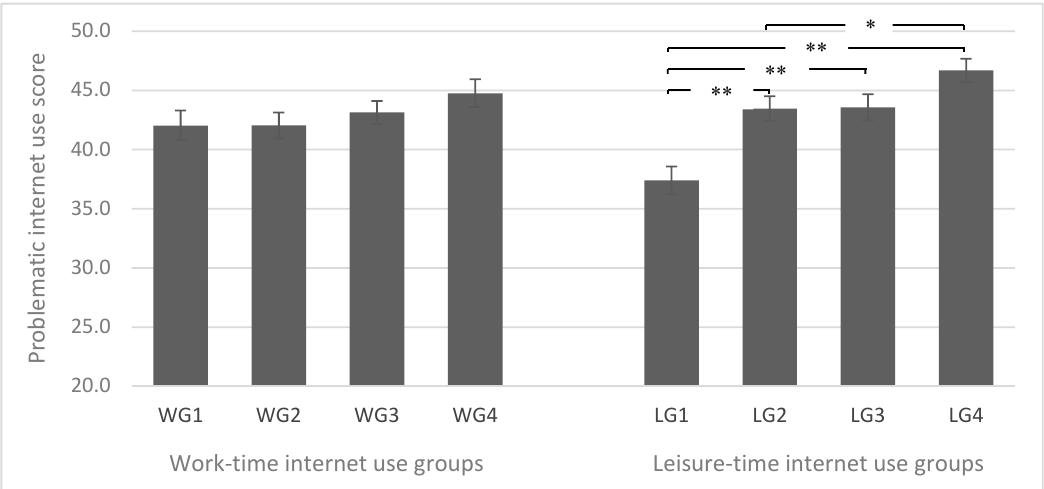
Figure 1. Means of problematic internet use in the four work-time internet use groups and four leisure-time internet use groups. WG1: work-time internet use group 1 (< 5 h/w); WG2: work-time internet use group 2 (5–13.99 h/w); WG3: work-time internet use group 3 (14–27.99 h/w); WG4: work-time internet use group 4 (28–60 h/w); LG1: leisure-time internet use group 1 (< 4 h/w); LG2: leisure-